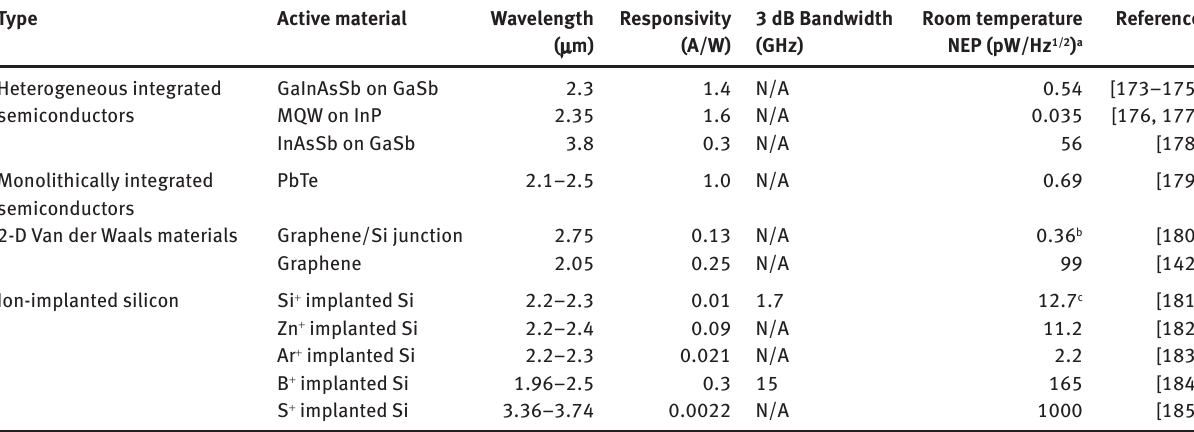
Table 5: Mid-IR waveguide-integrated photodetectors on Si.